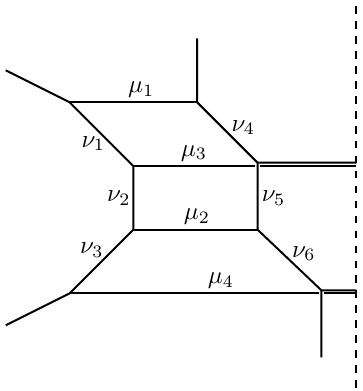
Figure 6 . 5-brane configuration for D 2 (2 , 2) gauge theory of overlapping sub webs.